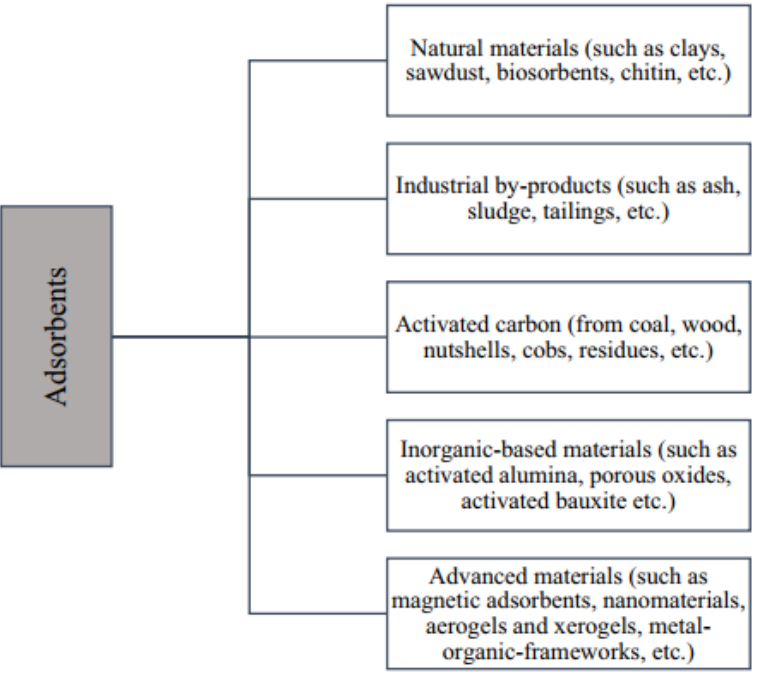
Figure 8. Classification of adsorbents. Source: [40].